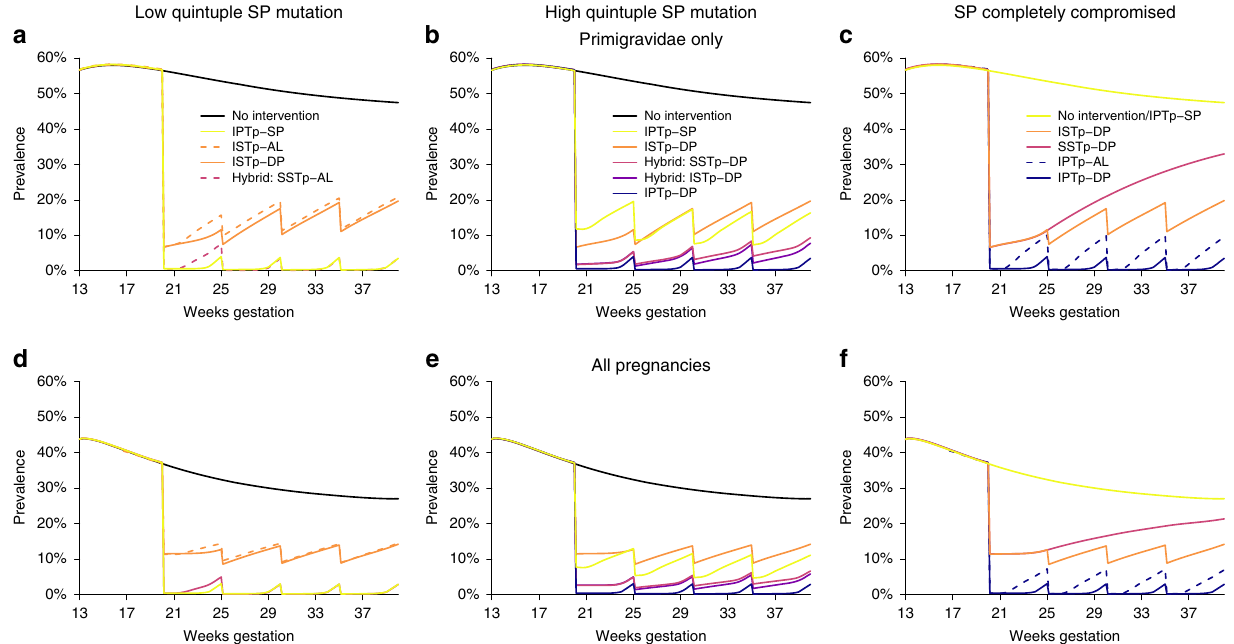
Fig. 4 Simulated incremental bene fi t of alternative strategies to IPTp-SP by level of SP resistance. Simulations are for high transmission settings (EIR = 100), top row shows peripheral PCR prevalence in primigravidae alone, bottom row averaged across all pregnant women. Left column, a and d , represent areas with low quintuple SP mutation, centre, b and e , with high quintuple mutation and right, c and f , represents a scenario with sextuple resistance where SP is assumed to no longer provide any protection. Simulations show the following strategies: no intervention (black lines), IPTp-SP (yellow lines), ISTp-DP (orange lines), Hybrid-SSTp (light purple lines), Hybrid-ISTp (dark purple lines) and IPTp-DP (blue lines). In general, for scenarios involving ACTs, simulations with DP are shown. In select situations simulations with shorter-acting AL are shown with dashed line. NB: In settings with low quintuple SP mutations, SP and DP are assumed to have equivalent ef fi cacy so IPTp and hybrid strategies involving these drugs are indistinguishable when SP has no impact, ISTp and hybrid strategies using the same treatment drug are